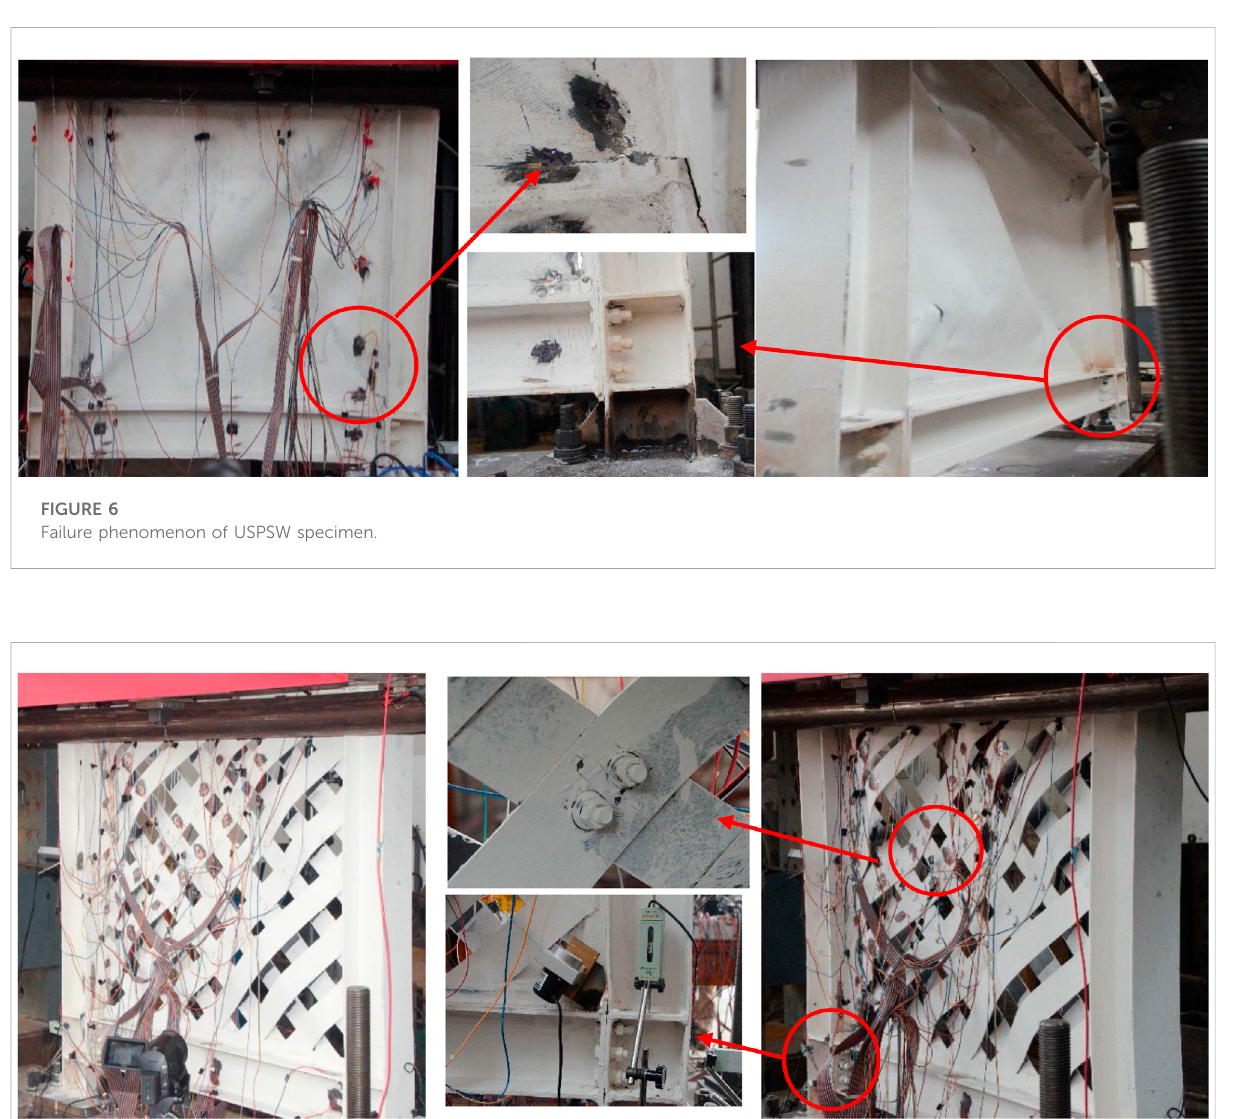
FIGURE 7 The IWS-SPSW specimen failure